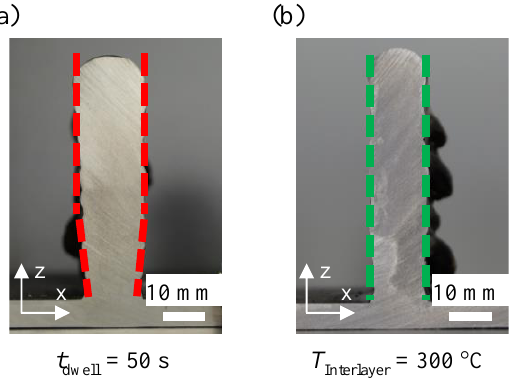
Figure 5. Cross-sections of walls manufactured with ( a ) a constant dwell time of 50 s and ( b ) a constant interlayer temperature of 300 °C; the dashed lines in color indicate the outer contours of the wall.